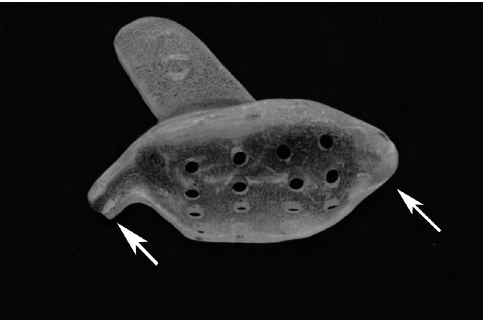
Figure 1. Custom acrylic resin partial tray. To standardize the thickness of the impression material (2.0-mm relief), the seating position, and to limit the pressure over the tray, extensions were made on the right maxillary lateral incisor and second molar (arrows). The trays were obtained and maintained in distilled water at 37ºC one week before impressions.